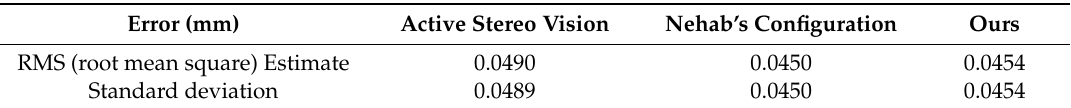
Figure 10. Distance deviation of the points from ground truth. ( a ) Points obtained by active stereo vision; ( b ) Points after applying Nehab’s algorithm, which uses normal vector from the traditional photometric stereo method; ( c ) Points after applying Nehab’s algorithm, which uses normal vector from the re-projection method. Table 1. Distance deviation of point data.